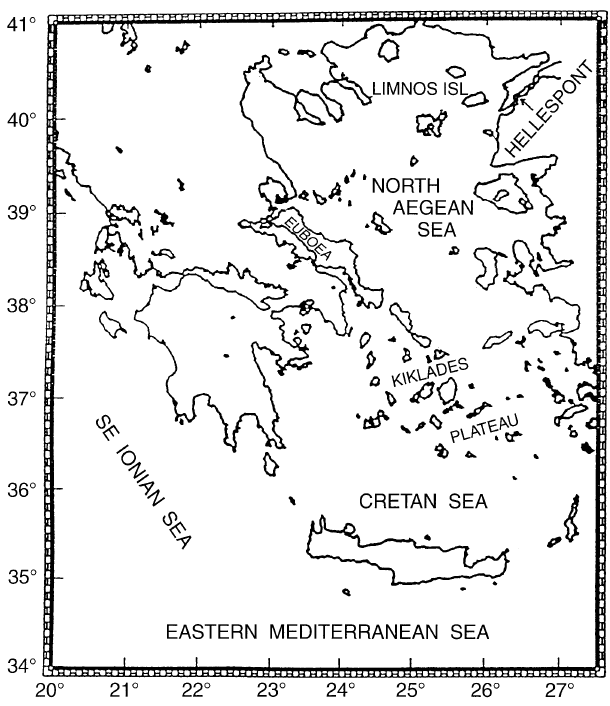
Fig. 1. Morphology of the Aegean